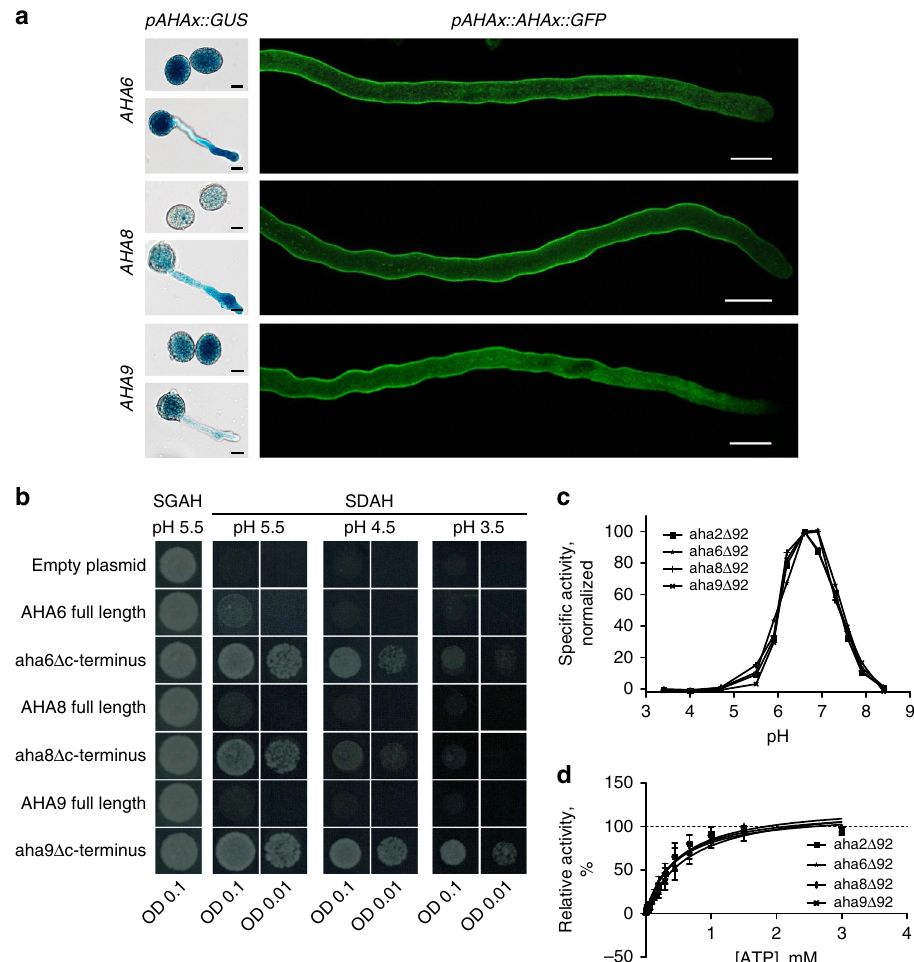
Fig. 1 AHA6, AHA8, and AHA9 are proton pumps localized in the plasma membrane of pollen tubes. a Left, Histochemical staining for GUS activity in pollen grains and grown pollen tubes stably expressing AHA promoter::GUS fusions and observed using a light microscope. Right, Pollen tubes stably expressing GFP-tagged AHA proteins under control of their endogenous promoters and observed using a confocal microscope (see also Supplementary Fig. 2b). AHA6::GFP and AHA8::GFP were expressed in the aha6/8 mutant and AHA9::GFP was expressed in the aha9 mutant. Scale bars = 10 µ m. b Mutated AHA6, AHA8, or AHA9 proteins lacking the autoinhibitory C-terminal domain, but not the full-length proteins, support yeast growth in the absence of its own plasma membrane proton ATPase, PMA1 . The yeast strain RS-72 used in this analysis has PMA1 under control of a galactose-inducible promoter and does not express the gene on glucose medium. c Speci fi c ATPase activity of recombinant full-length and C-terminally truncated AHA proteins assayed between pH 3.5 and pH 8.5. d Speci fi c ATPase activity of recombinant full-length and C-terminally truncated AHA proteins assayed at pH 6.5 and with various ATP